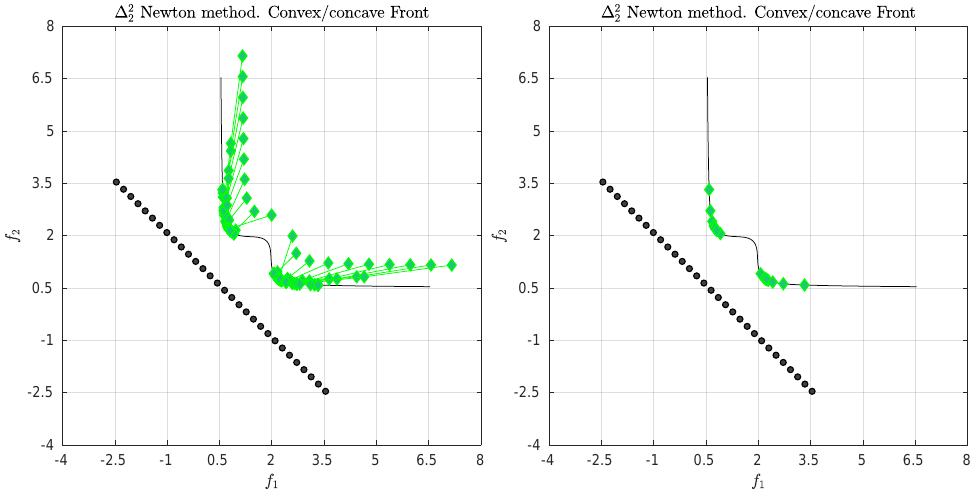
Figure 13. ( Left ) application of the ∆ 2 -Newton method on BOP (51). ( Right ) the final archive. Table 7. Numerical results of the ∆ 2